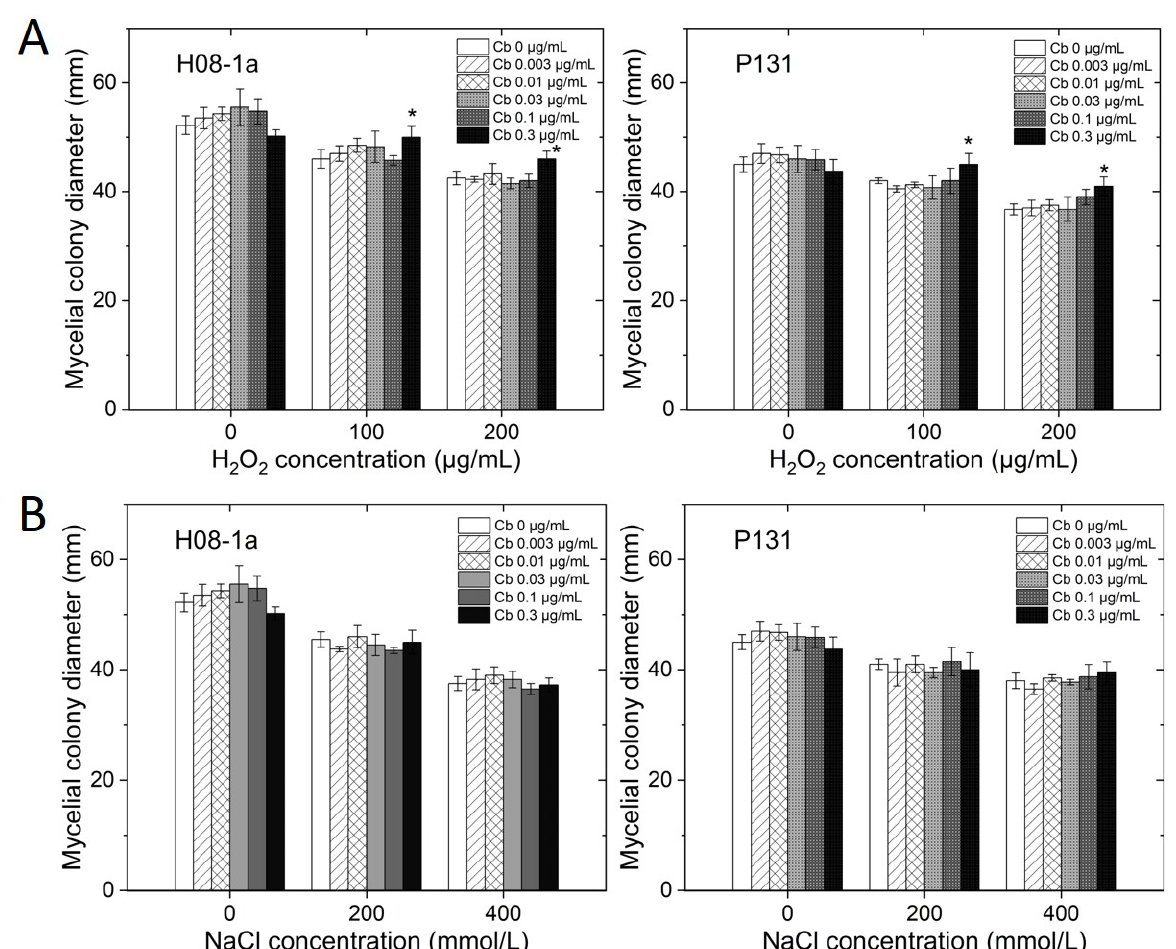
Figure 2. Effects of carbendazim on tolerance of Magnaporthe oryzae isolates H08-1a and P131 to H 2 O 2 ( A ) and NaCl ( B ). Error bars represent the standard errors of mean values in independent experiments. Asterisk indicates significant difference ( p < 0.05) between the treatment and the control without pretreatment.